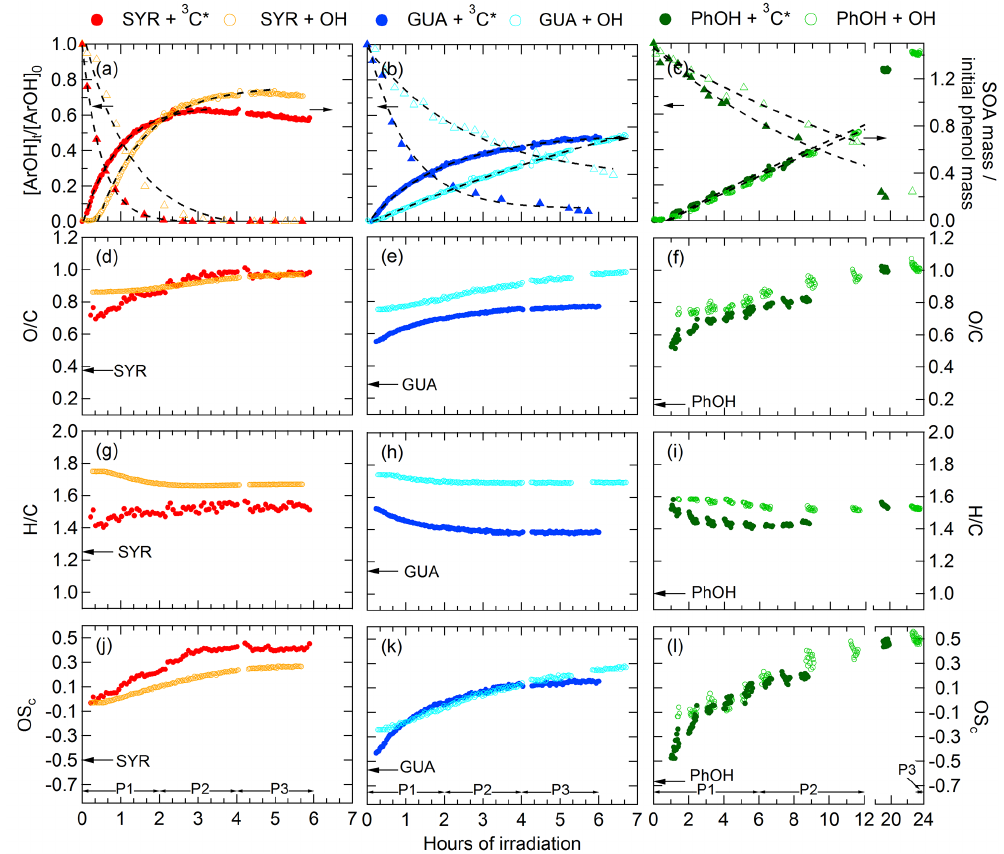
Figure 1. Evolution of (a–c) concentration of phenol precursors (left axes) and aqSOA mass (right axes) normalized by the initial concen- tration of precursor, (d–f) O / C of aqSOA, (g–i) H / C of aqSOA, and (j–l) OS C of aqSOA as a function of reaction time during individual experiments. The aqSOA mass and elemental ratios are determined from AMS data and precursor concentrations are measured by HPLC. In panels (a–c) , phenol precursors are represented by solid and open triangles and aqSOA by solid and open circles. The two different oxidants are represented by the symbols shown in the legend on the top of the figure. The lines in panels (a–c) represent the regression fits to each set of experimental data and the fit parameters are summarized in Table 2. The O / C, H / C, and OS C values of individual phenolic precursors are indicated by the arrows in panels (d–l) . The three reaction periods (P1–P3) for which filter samples were collected for nano-DESI MS analyses are marked in panels (j–l) . Table 2. Summary of the kinetics of the destructions of phenolic precursors and formation of aqSOA during simulated sunlight illumination. The error range calculation is based on the 95% confidential interval. SYR GUA PhOH • OH 3 C ∗ • OH 3 C ∗ • OH 3 C